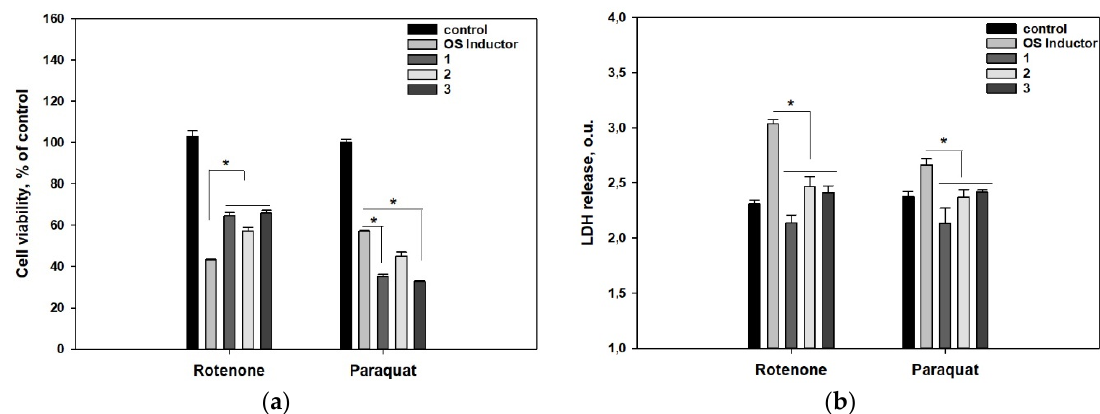
Figure 2. Influence of polyketides 1 – 3 on the viability estimated using MTT assay ( a ) and LDH release ( b ) in Neuro-2a cells treated with OS inductors, rotenone, and paraquat. Data are presented as mean ± standard error mean (SEM). * indicates significant differences ( p ≤ 0.05). Differences between control and rotenone or paraquat were significant.